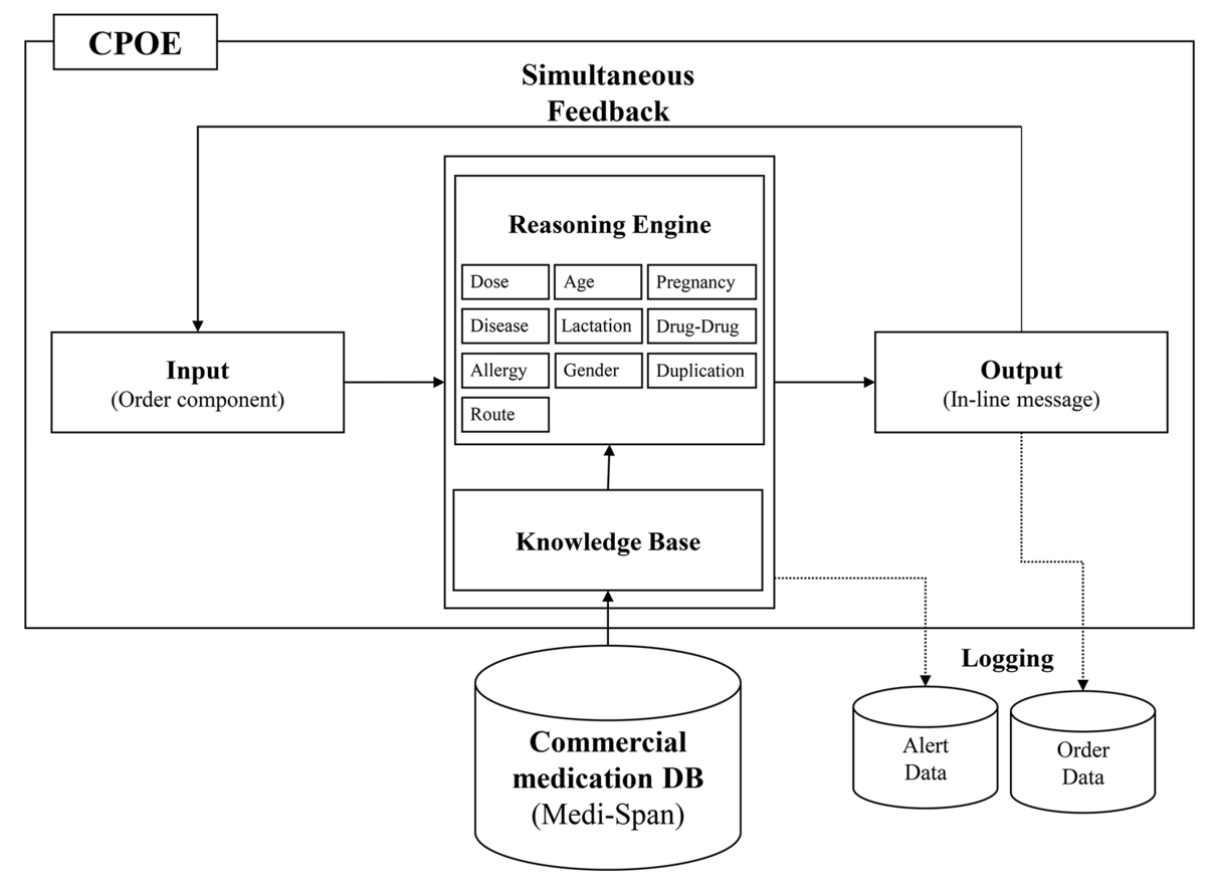
Figure 2. System architecture of the computerized provider order entry (CPOE). DB: database.